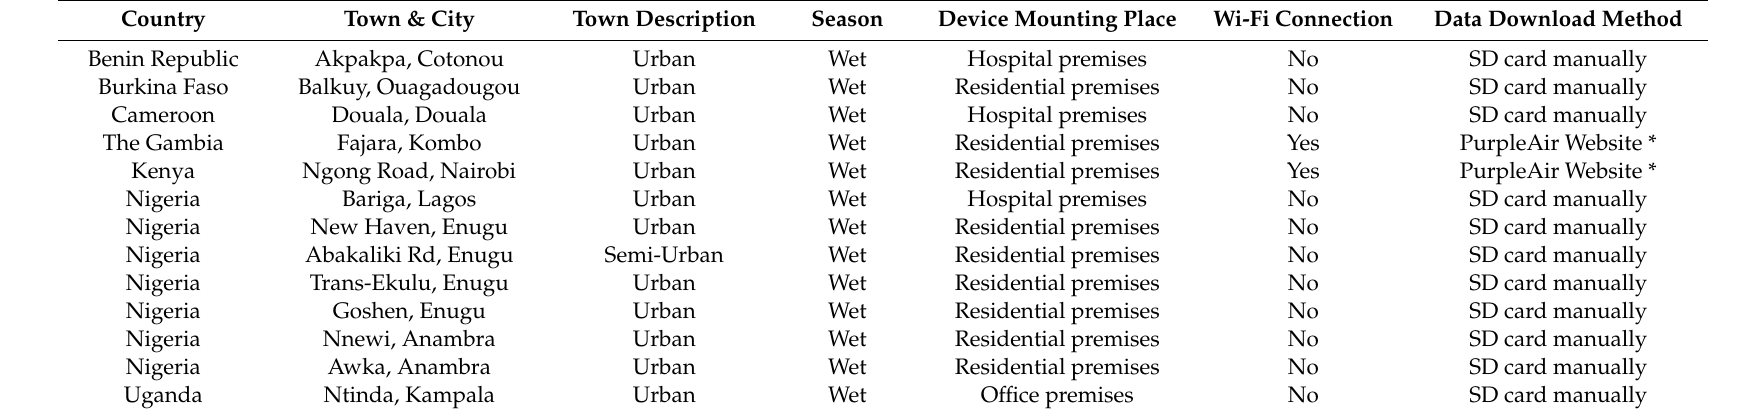
Table 1. Characteristics of the 13 Sites Participating in the MA3 Pilot Study (July 2019).